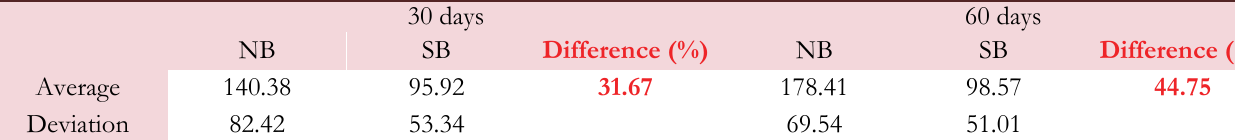
Table 5: Corrosion depth ( μ m).